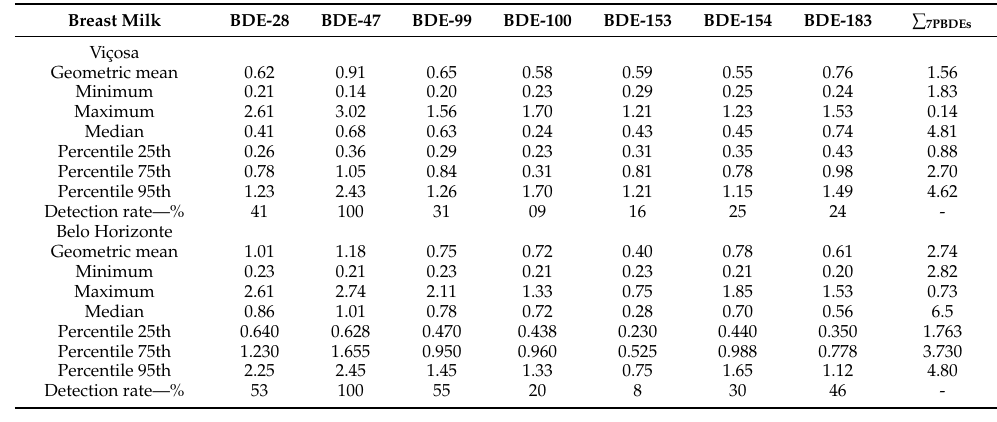
Table 2. Concentrations of PBDE congeners in breast milk samples in both Brazilian locations (Belo Horizonte and Viçosa). The values are expressed as ng/g wet weight. Breast Milk BDE-28